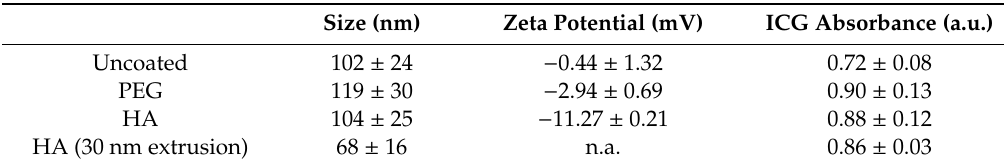
Table 1. Physico-chemical properties of the liposome formulations produced for the experiments (mean of triplicate measurements with SD). ICG—indocyanine green; PEG—polyethylene glycol; HA—hyaluronic acid; n.a.—not available.